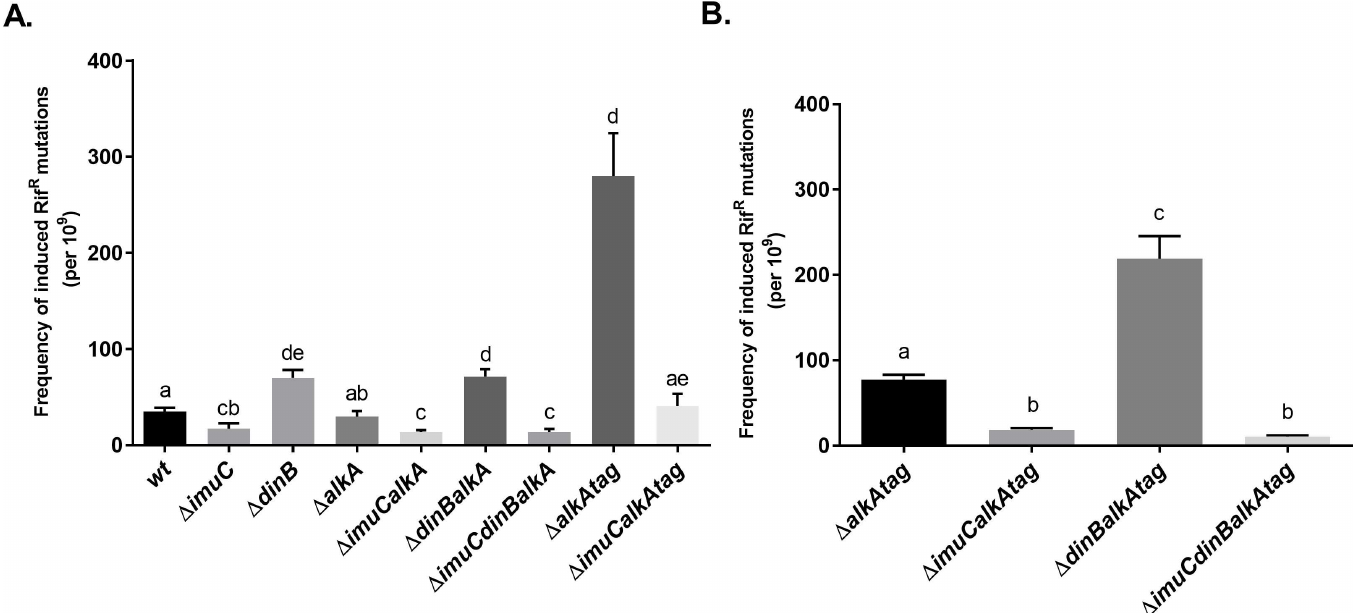
Fig 7. Effect of TLS polymerasedeficiencies on the frequencies of MMS-induced Rif R mutations in P . putida wild type and alkA - and alkAtag - deficient backgrounds. Bacteria were exposedto 0.15 mM MMS (A) or to 0.05 mM MMS (B) overnight. Data representsthe mean ( ± SE). Letters indicate homogeneous groups. Groups that have no common letter are significantly different at P < 0.05, accordingto Kruskal-Wallis test followedby Dunn’smultiple comparisons test (e.g., group with the letter ‘a’ is significantly different from the group with the letters ‘cb’, but not from the groups with the letters ‘ab’ or